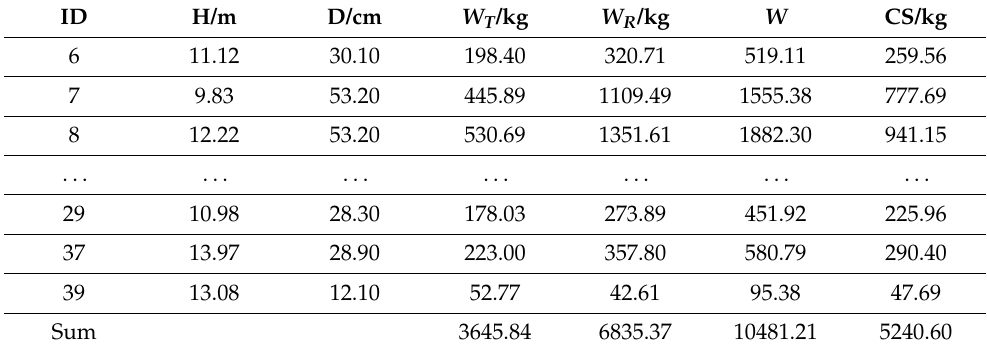
Table 6. Calculation of cypress carbon